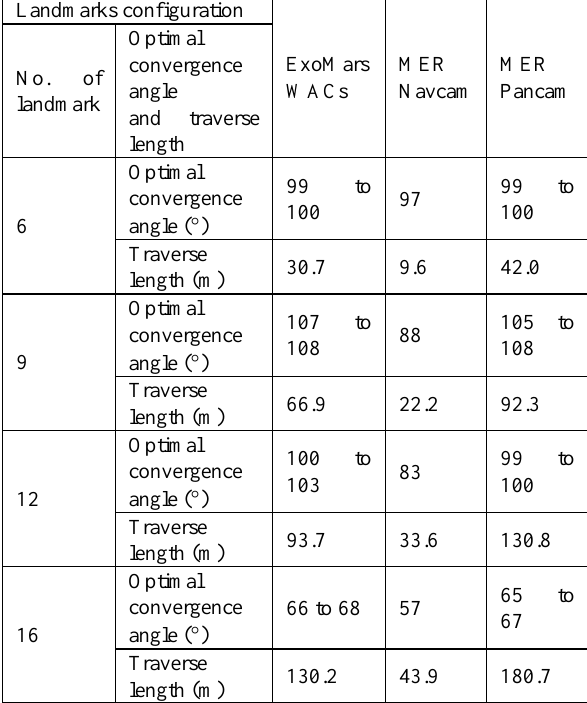
Table 1. Landmarks configuration and rover localization accuracy.